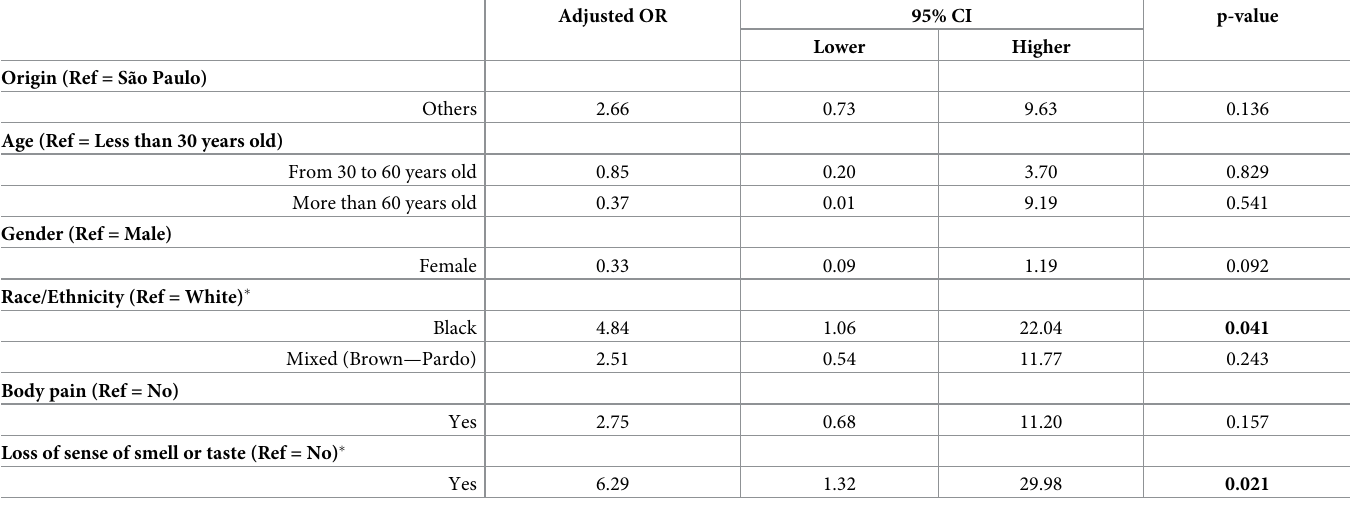
Table 4. Final logistic model for the analysis of risk or protective factors associated with seropositivity of anti-SARS-CoV-2 IgG in 87 shelter workers of S ã o Paulo,